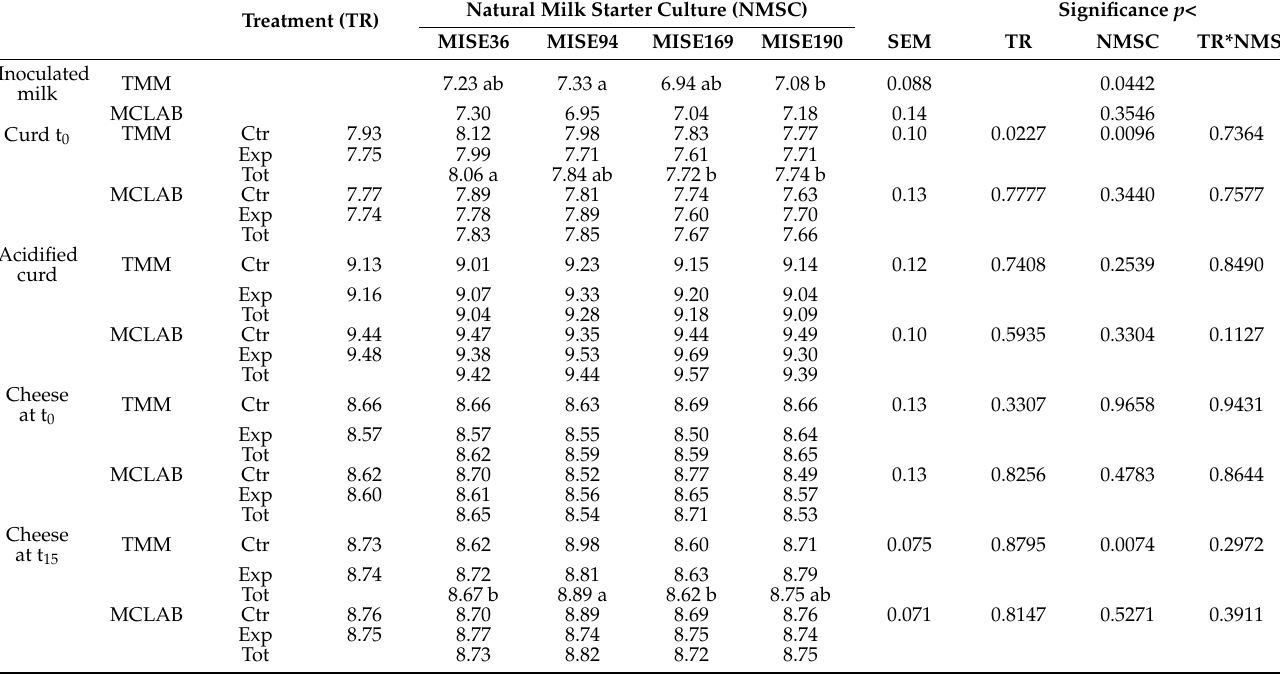
Table 2. Microbial evolution a during experimental cheese